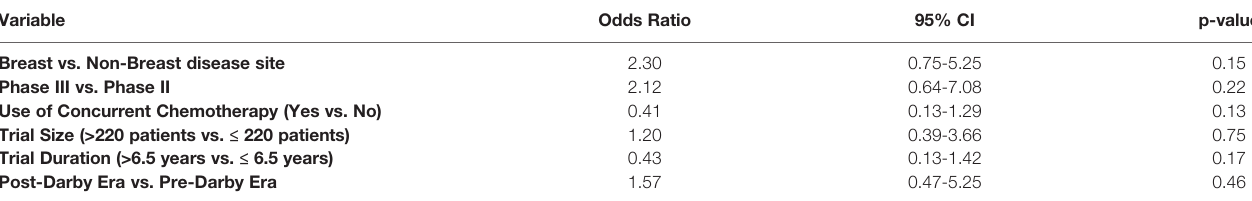
TABLE 2 | Logistic regression analysis of association of radiation clinical trial characteristics and inclusion of a cardiac primary or secondary endpoint.